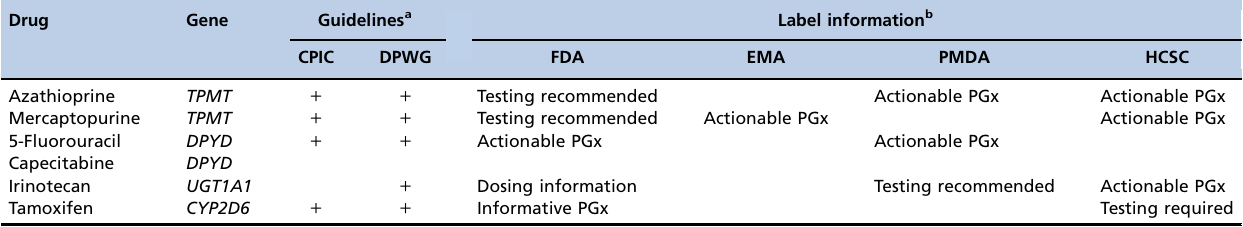
Table 1 - Guidelines and label information for germline variants in pharmacogenes associated with antineoplastic